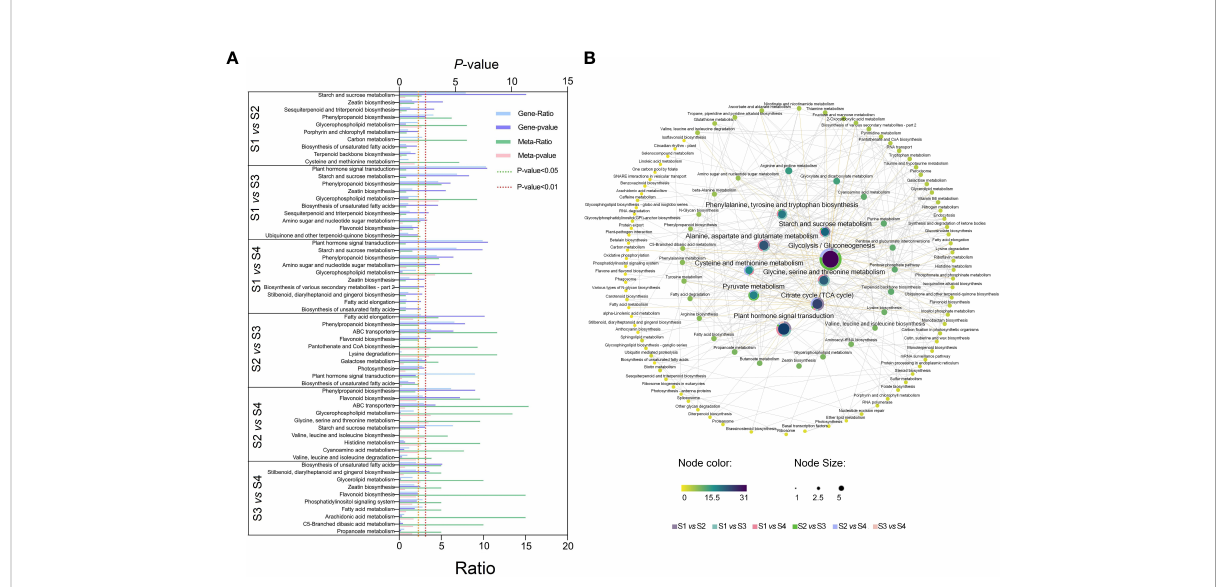
FIGURE 5 KEGG pathway annotated analysis in different lettuce stem expansion stages (S1, S2, S3, and S4 stages). (A) The top 10 pathways associated with transcriptome and metabolome. Ratio: the number of differential metabolites or differential genes enriched in this pathway/the number of metabolites or genes annotated in this pathway. (B) Correlation analysis of each pathway. Different dots represented different metabolic pathways; yellow to purple indicated the degree of enrichment in the whole expansion stage, and the central fan chart displayed the degree of enrichment of the pathway in each comparison group. The data were calculated by -log10 ( p -value), and the higher the value, the greater the